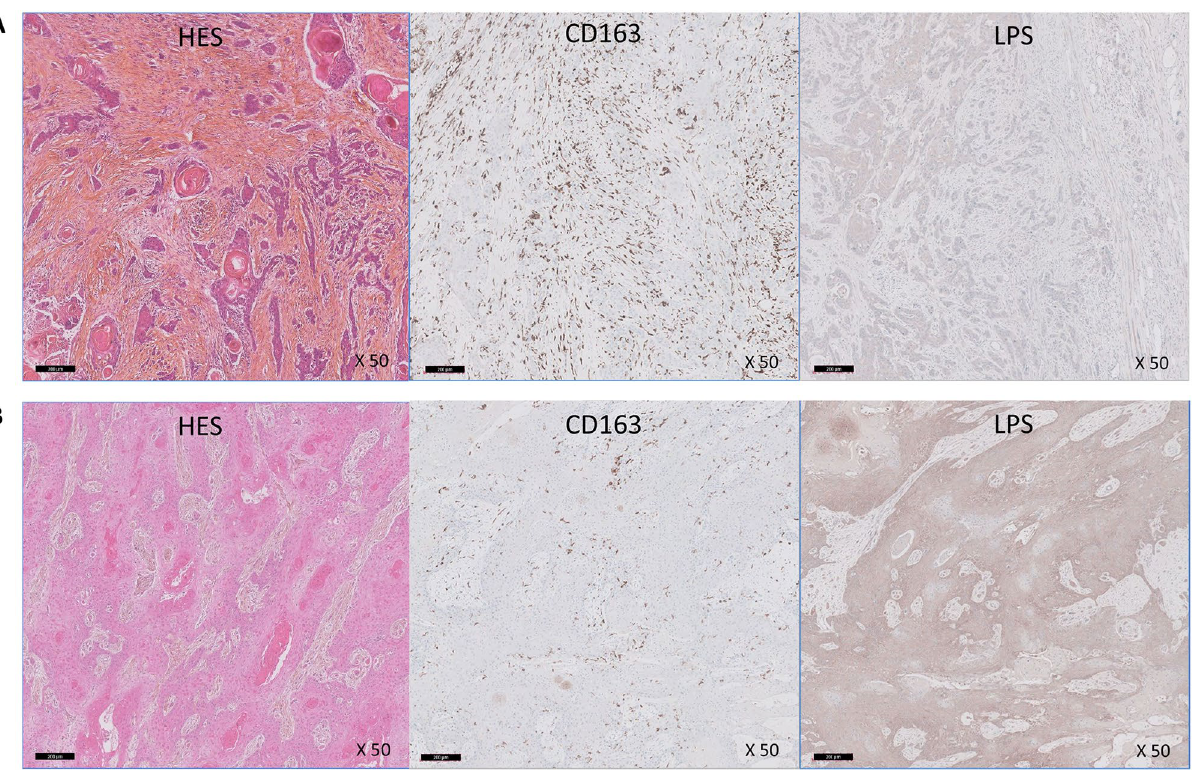
Figure 5. Representative pictures of infiltrating squamous cell carcinomas of the oropharynx: hematoxylin– eosin–safran (HES) stained slides, CD163 and lipopolysaccharide (LPS) immunostainings in a CD163 high/ LPS low case (CD163: Histologic Score [HS] 3 (> 50%), LPS: slight expression; F. nucleatum negative) ( A ) and in a CD163 low/LPS high case (CD163: HS 1 (< 25%), LPS: strong expression; F. nucleatum positive) ( B ) (scale bar = 200 µM; original magnification: